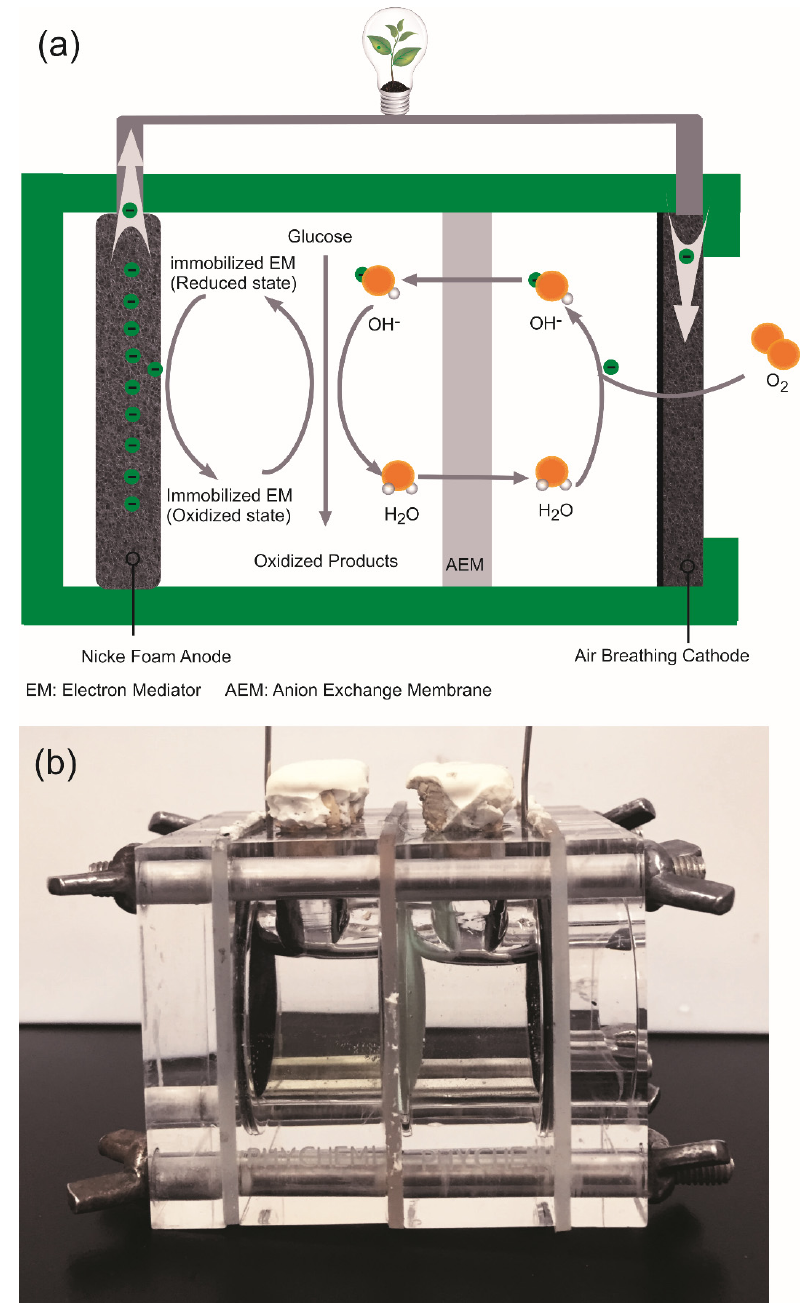
Figure 8. Schematic of the structure ( a ) and photograph ( b ) of the two ‐ chamber DGAFC.